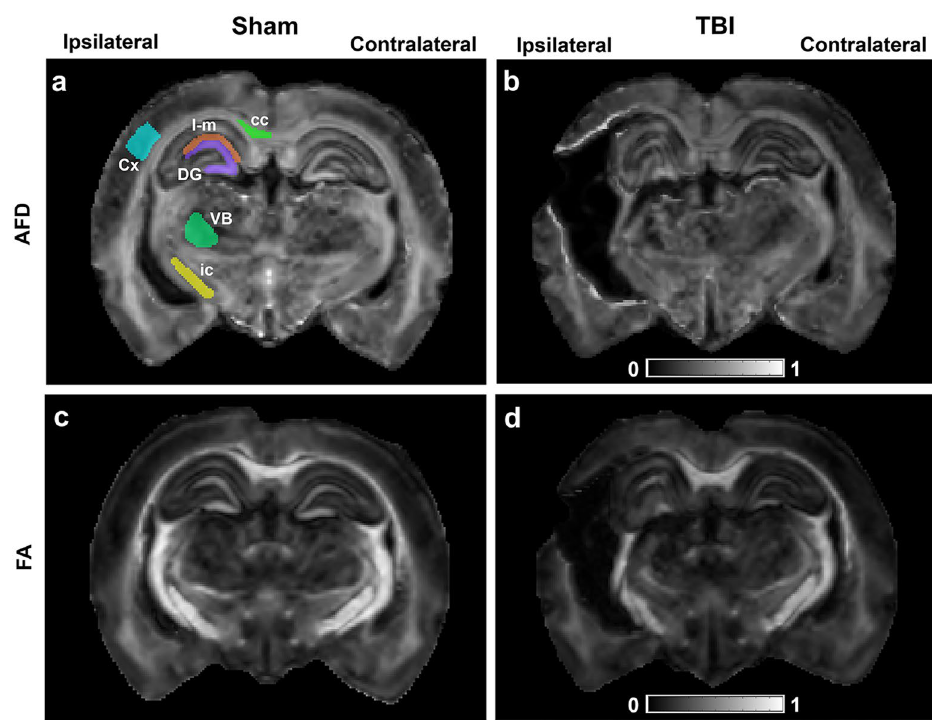
Figure 1. Representative AFD ( a , b ) and FA ( c , d ) maps from a sham-operated ( a , c ) and TBI ( b , d ) rat brain. Regions-of-interest were delineated on three consecutive slices at − 3.80 mm from bregma. Abbreviations: AFD, apparent fiber density; cc, corpus callosum; Cx, perilesional cortex; DG, dentate gyrus; FA, fractional anisotropy; ic, internal capsule; l-m, stratum lacunosum-moleculare; VB, ventrobasal